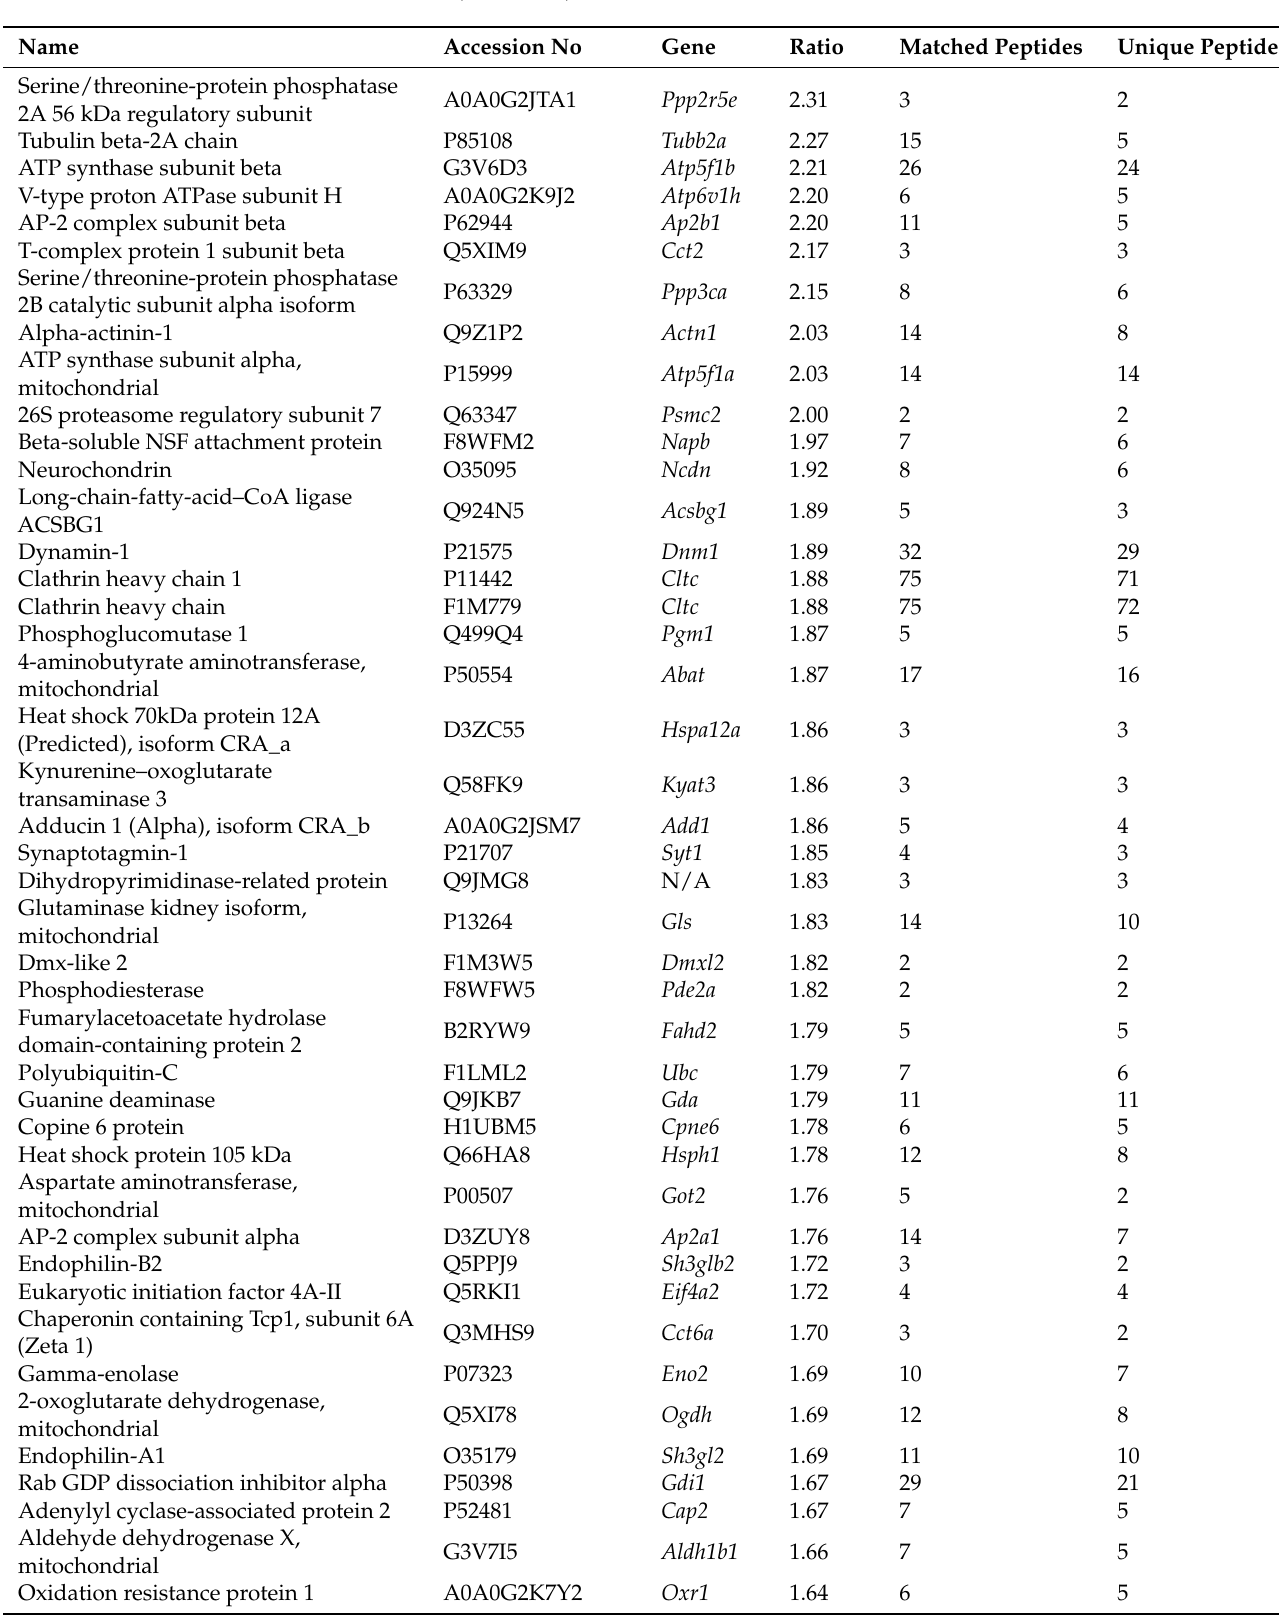
Table 3. Synaptosomal differentially expressed proteins in fluoxetine-treated chronically socially isolated rats (CSIS + Flx) vs.